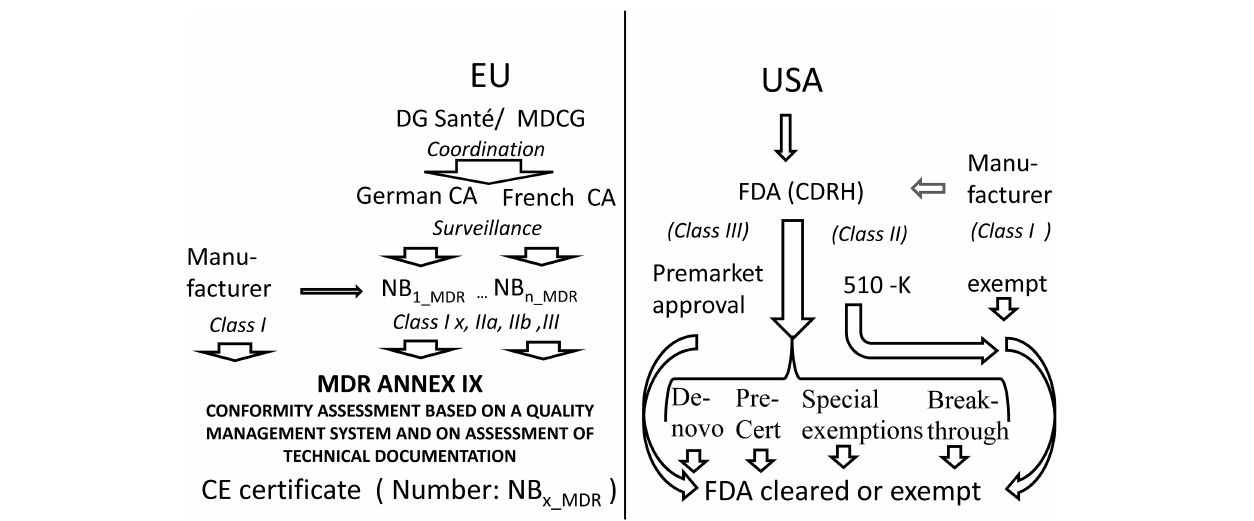
FIGURE 1 | Comparison of access to the market in Europe as compared to the United States. MDCG Medical Device Coordination Group, CA Competent Authority, NB Notified Body, MDR Medical Device Regulation, CE certificates issued by a notified body bear a number identifying the notified body, FDA US Food and Drug Administration, CDRH FDA Center for Devices and Radiological